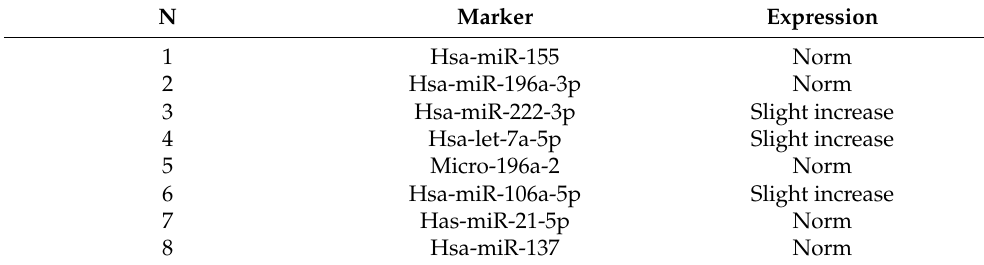
Table 2. miRNA expression in patient P at the initial investigation.